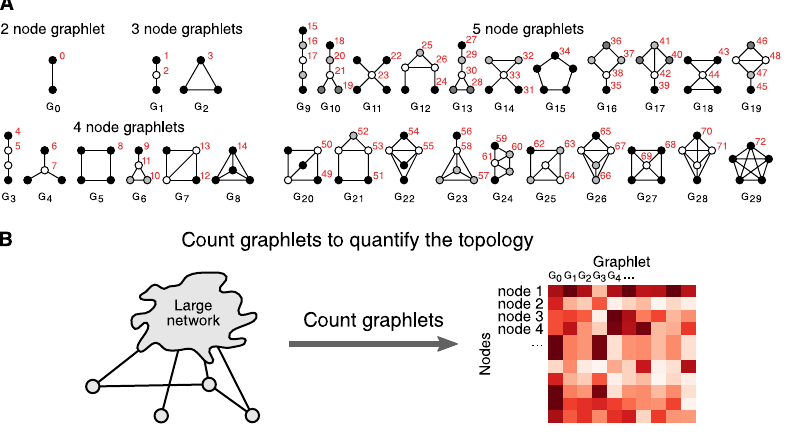
Fig 1. Graphlet counting in a network characterises its local topologies. (A) In total, there are 30 different graphlets containing 2 to 5 nodes, ranging from G 0 to G 29 . Orbits are an extension of graphlets which also take into account the position of a node within a graphlet. The 73 different orbits are coloured in red. (B) By counting the occurrences of these graphlets in the network, the local topology surrounding a node can be quantified.